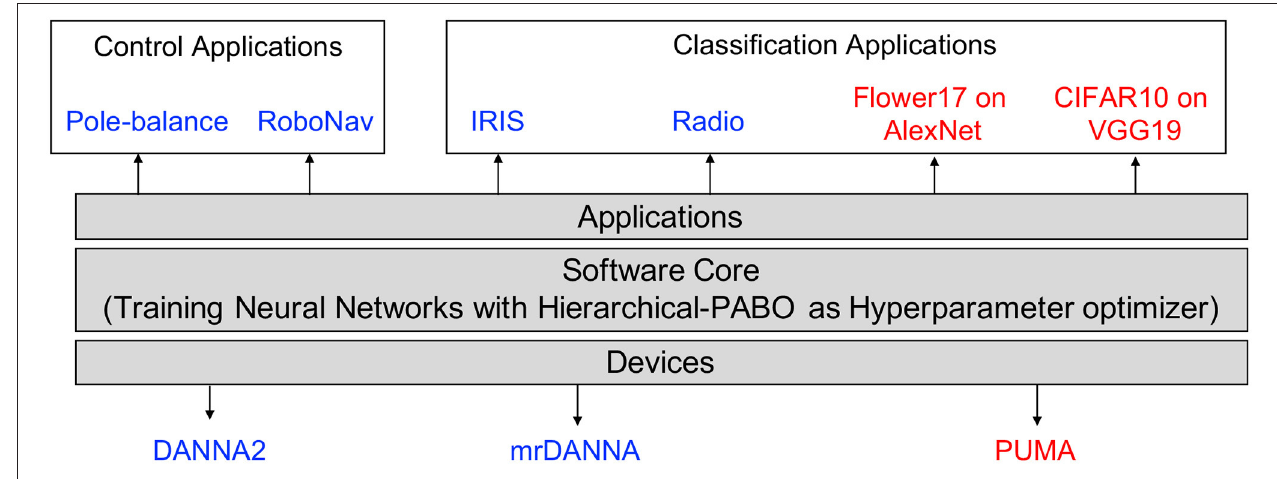
FIGURE 3 | Summary of the experimental setup (ANN and